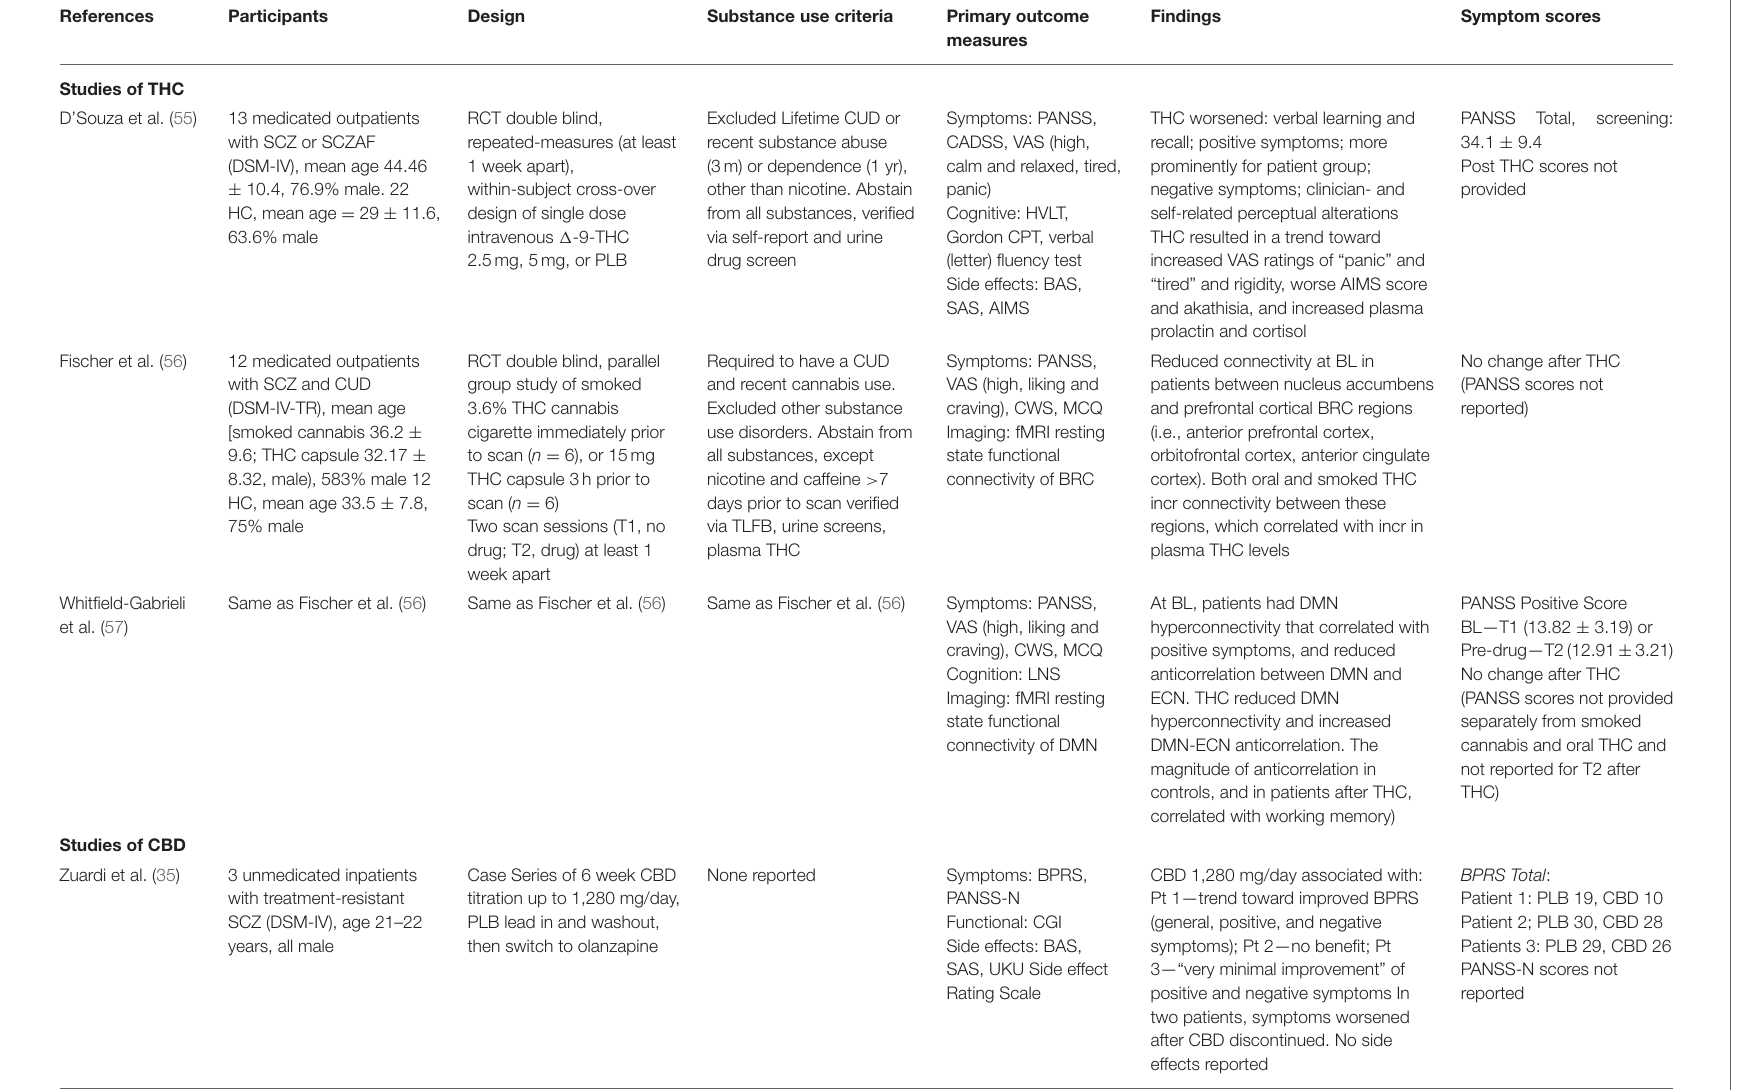
TABLE 1 | Methods and results of studies of CBD and THC in the treatment of